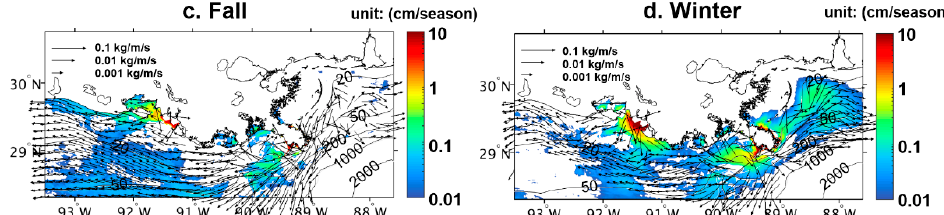
Figure 12. Spatial distributions of 20-year averaged annual sedimentation rates and suspended